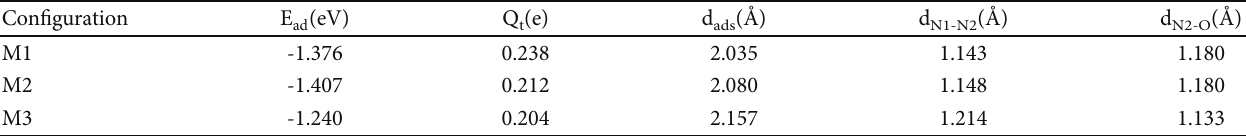
O adsorbed on Al-Graphene ((a) M1 top view; (b) M1 side view; (c) M2 top view; (d) M2 side 2 Table 3: The E , Q , and structural parameters of the N ad t